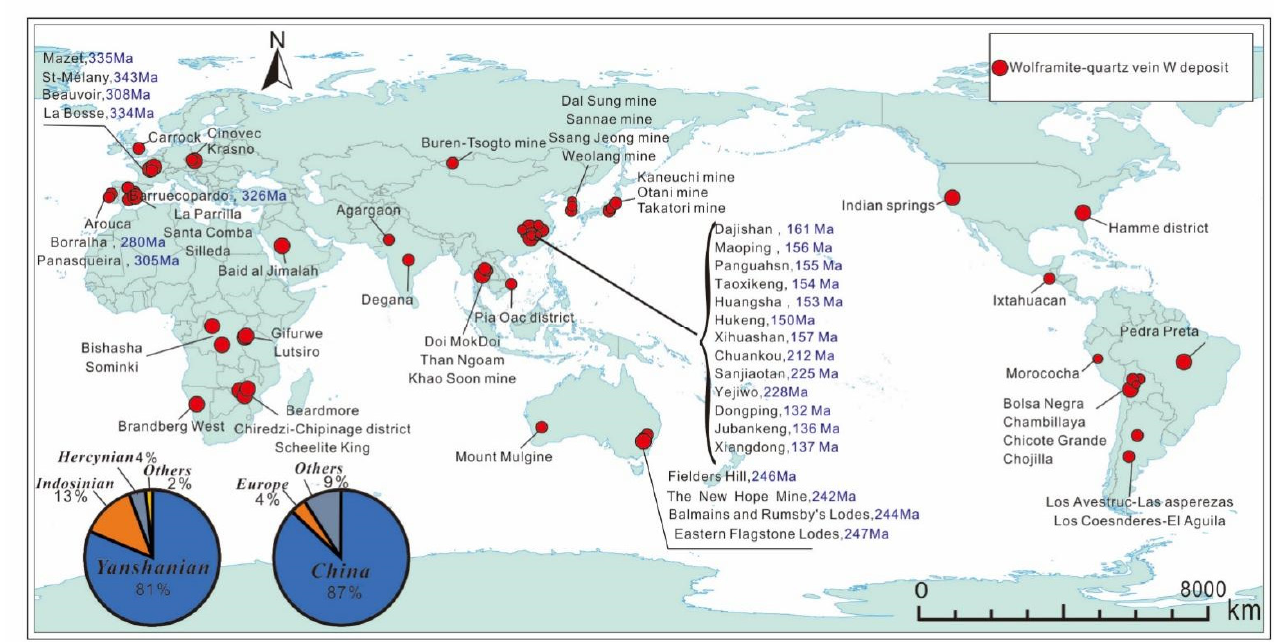
Figure 1. Global distribution of wolframite-quartz vein tungsten deposits. The distribution is shown schematically to highlight the belts and to demonstrate the diverse mineralization ages.